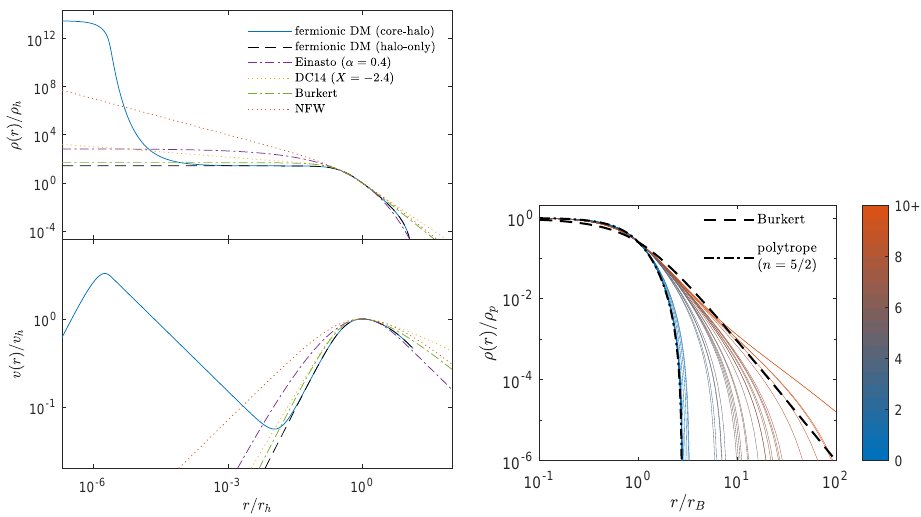
Figure 10. ( Left ): Density profile ( top ) and rotation curve ( bottom ) for selected DM models for the typical configuration parameters presented in [37]. The core − halo solution of the RAR model is illustrated by the configuration parameters β 0 = 10 − 7 , θ 0 = 30 and W 0 = 60, in combination with a corresponding halo − only solution. Other DM models (NEW, DC14, Burkert, Einasto) are added for comparison. All profiles are normalized to the halo radius r h , defined at the halo velocity maximum, with ρ h = r ( r h ) and v h = v ( r h ) . ( Right ): Best − fit DM density RAR profiles (outer region) to the full SPARC sample considered in [37] (in solid) for different values of the cutoff parameter W ( r pl ) ≡ W p : the outer halo of the RAR model can range from polytropic − like (polytropic index n = 5/2 in dot − dashed) to power law − like (e.g., ρ ∝ r − 3 ), resembling the Burkert profile (in dashed lines). Reproduced from